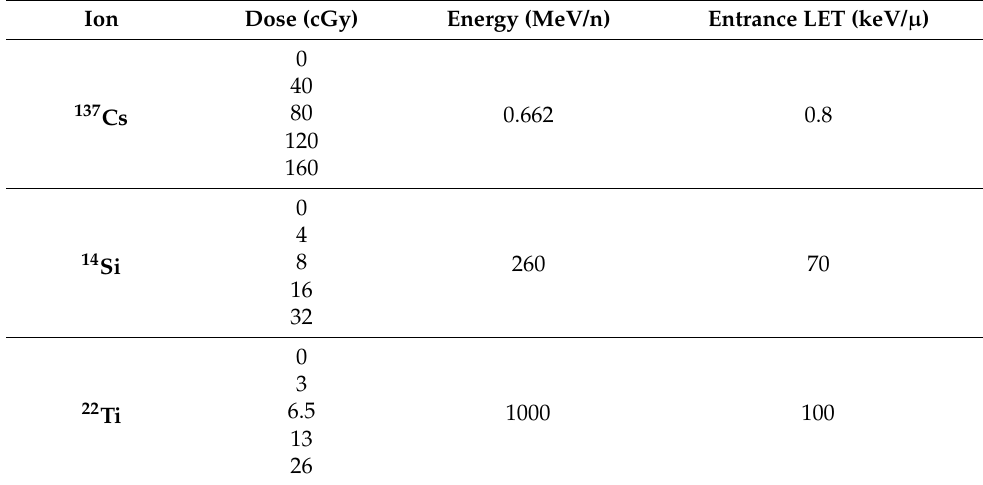
Table 1. Ionizing radiation types. Beam energies, doses, and LET used in this